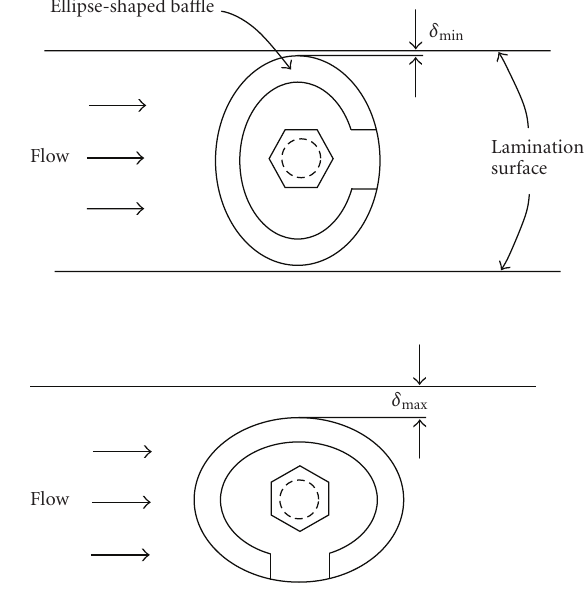
Figure 12: Adjustment of cooling flow with an ellipse-shaped ba ffl